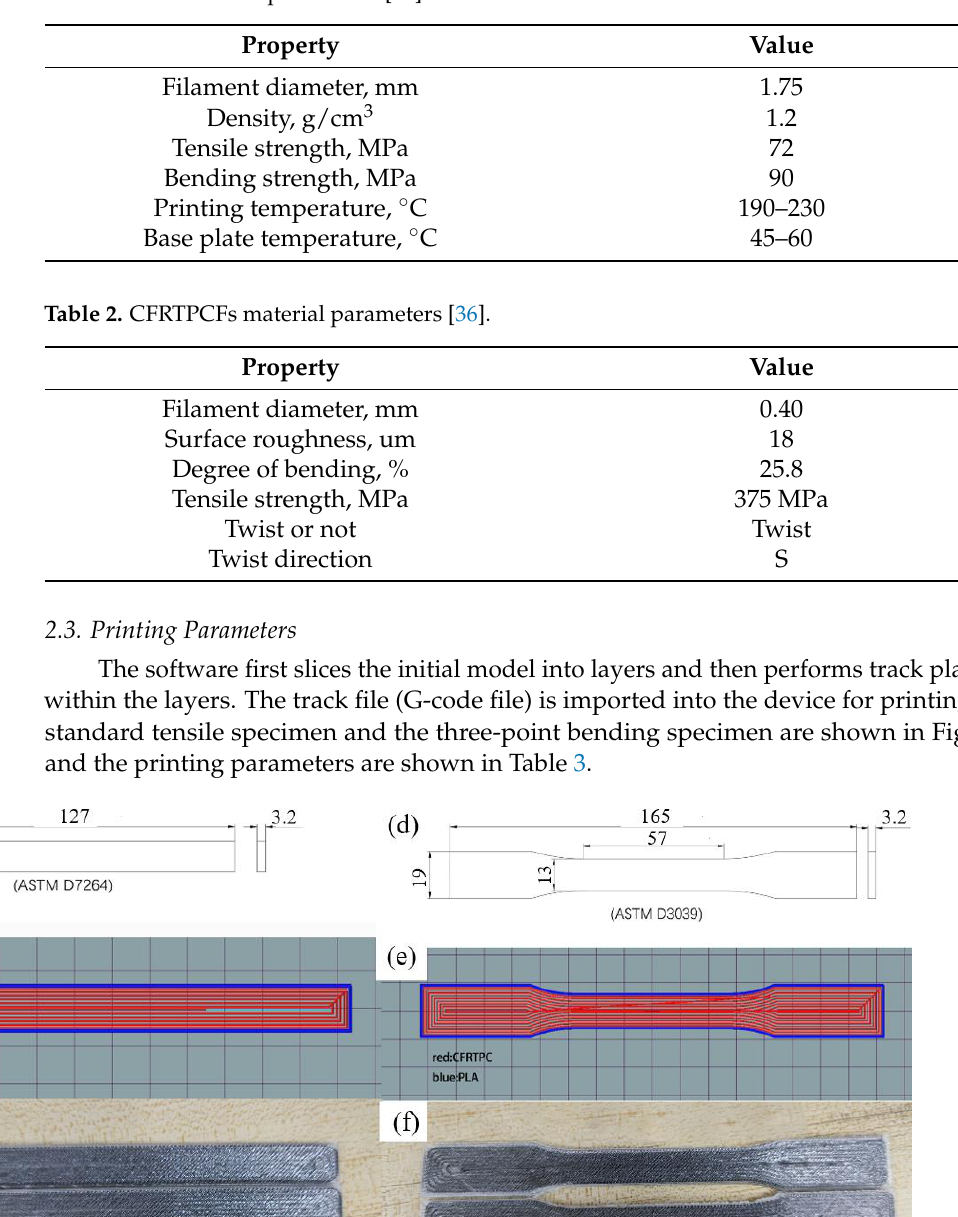
Table 1. PLA material parameters [35].